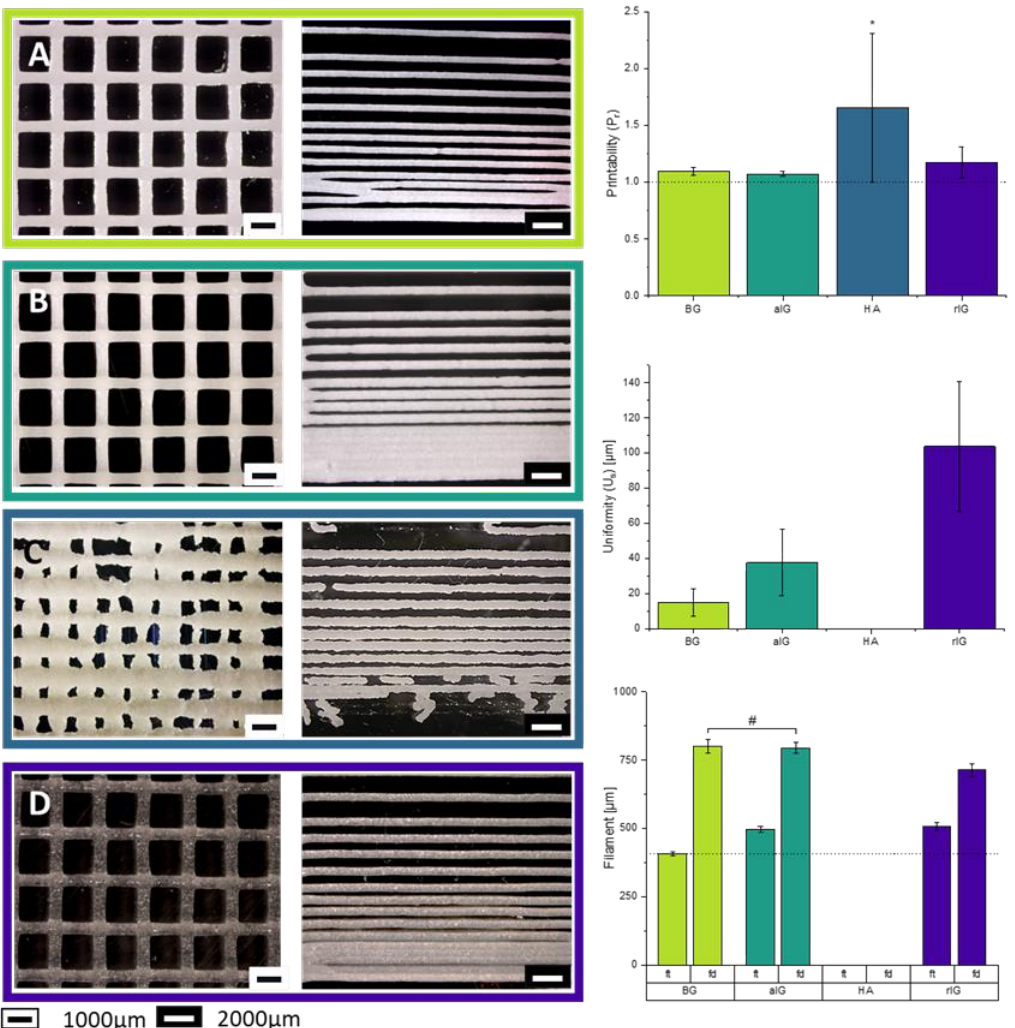
Figure 8. Light microscopy images of printed grids ( left ) and resolution trees ( middle ). ( A ) Ink BG, ( B ) ink aIG, ( C ) ink HA, ( D ) ink rIG. Diagrams show the printing performance results of printability (P r ), uniformity (U S ), filament thickness (f t ) and filament distance (f d ) ( right ). Statistical analysis using one-way ANOVA indicated a significant difference (* p < 0.05) for all samples. Samples labeled with # are found to be an exception.